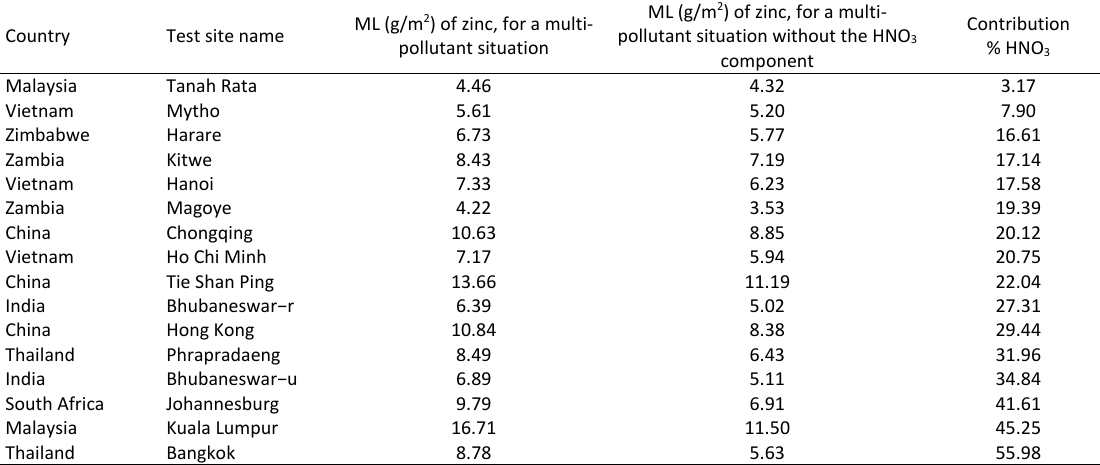
Table 3. Estimation of the % contribution of HNO 3 to the zinc corrosion rate (g/m 2 ) for different test sites